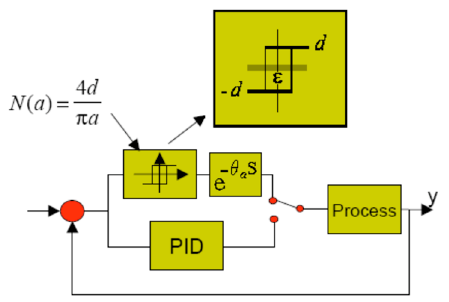
for the time delay and their corresponding frequencies are needed to start the iteration.